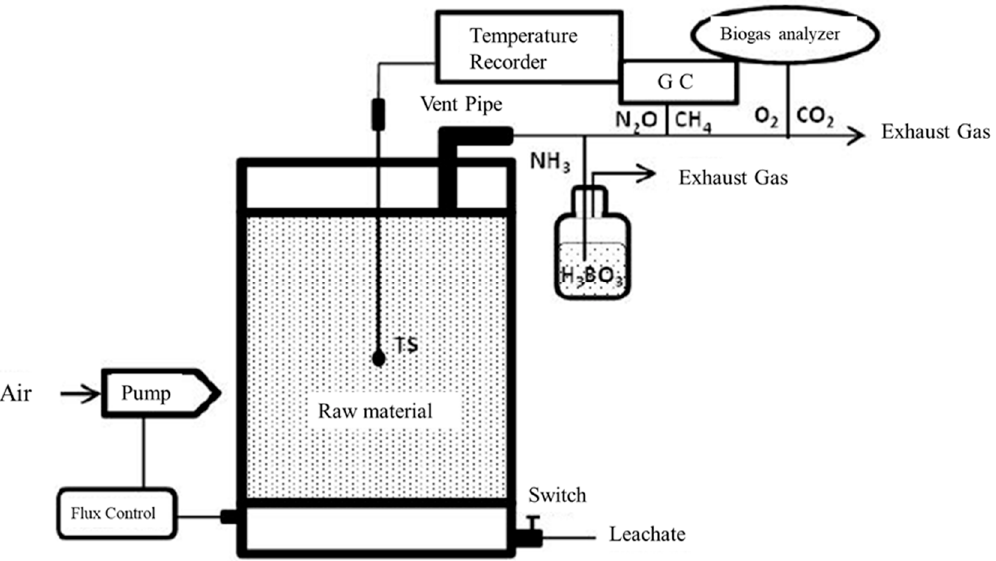
Figure 1. Diagram of forced aeration composting reactor.